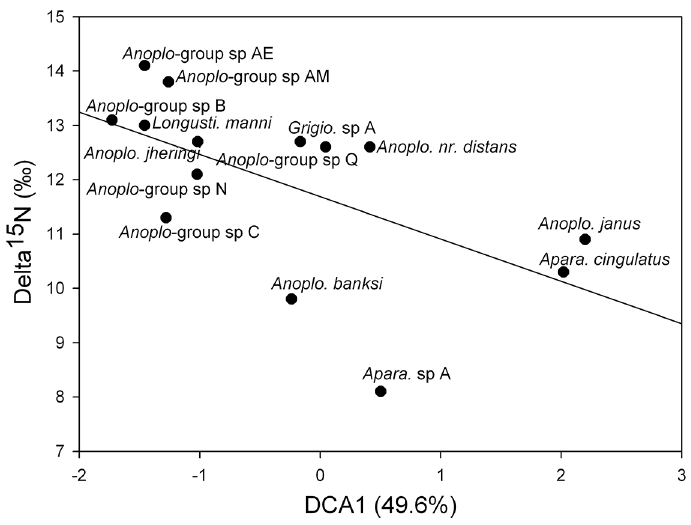
Fig 2. Scatter plot showing the correlation between species coordinates along the first axis of the DCA and δ 15 N isotopic values measured in [30].